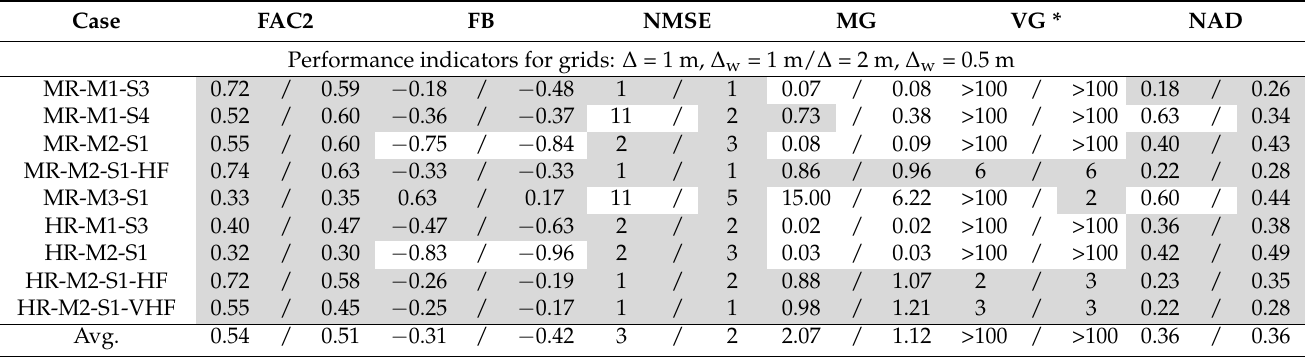
Table 6. Quantitative performance indicators for heavy gas releases for all investigated cases for two different meshes ( ∆ = mesh size, ∆ w = refined mesh size at walls). In grey: performance indicators which met the thresholds.